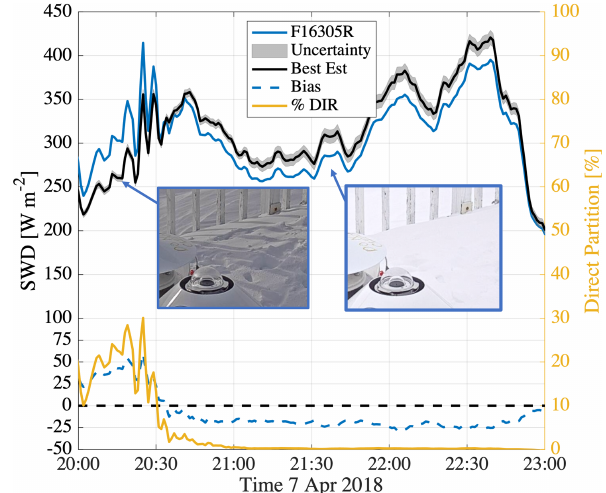
Figure 5. Case study of SWD on 7 April 2018. The solid black line and grey shading are the best estimate and uncertainty; the solid blue line is an iced pyranometer shown in the inset images. The dashed blue line is the bias in the solid blue relative to the solid black, and the yellow line shows the percent of the irradiance con- tributed by the direct beam: when this value is near zero, the lighting is diffuse under overcast